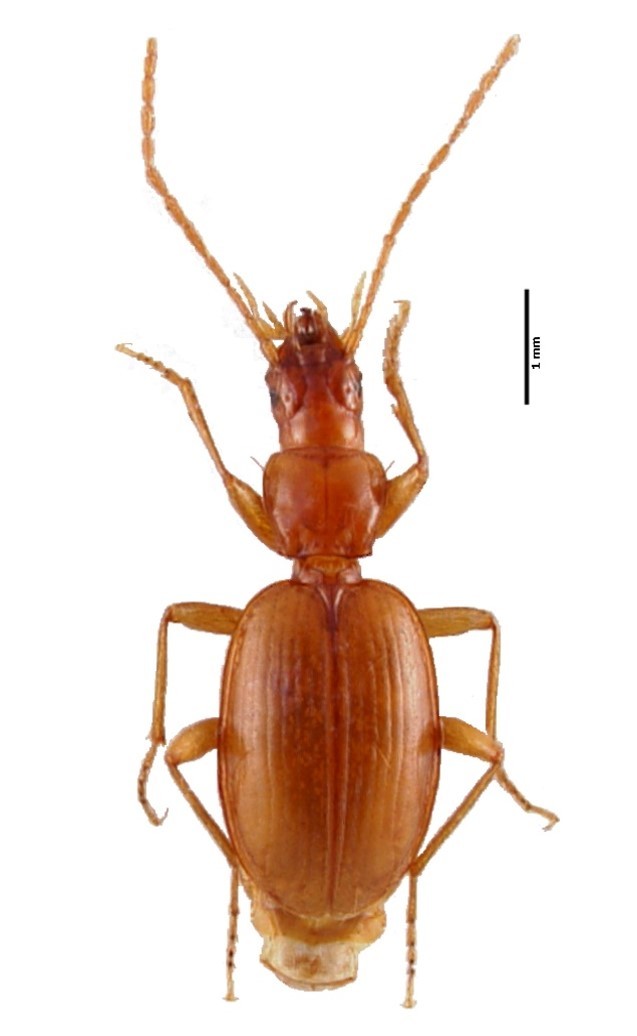
Trechus
picoensis (Machado, 1988) from Pico island (Azores, Portugal) (Credit: Enésima Mendonça; Azorean Biodiversity Group, cE3c).